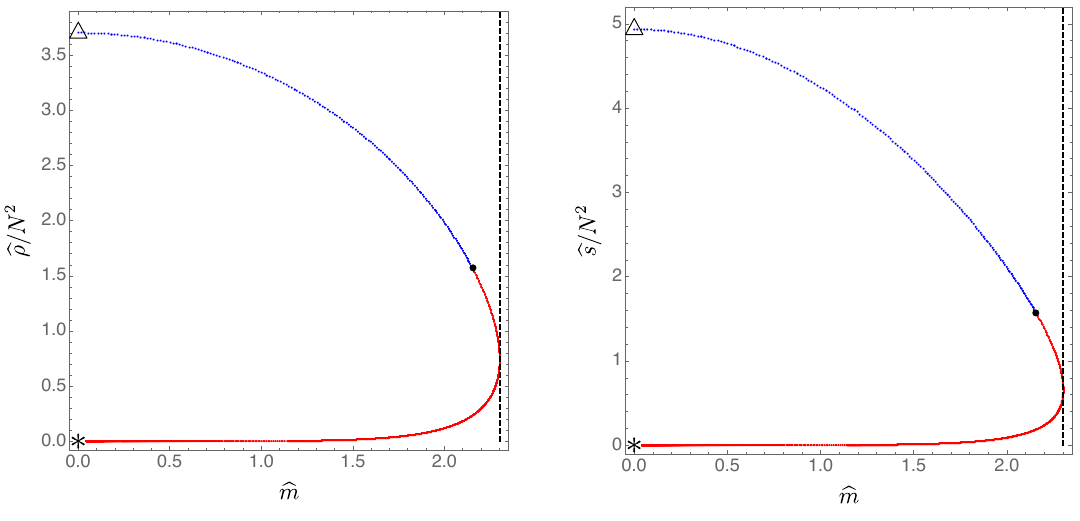
Figure 1 . Energy density (cid:26) ( left panel ) and entropy density s ( right panel ) as a function of the b b mass deformation m (solutions with no gaugino condensate, (cid:27) = 0). The vertical dashed line b intersects the turning point at m = m t (cid:24) 2 : 30; see (3.31). The solution marked with a triangle 4 b b (with m = 0, (cid:26) 6 = 0 and s 6 = 0) corresponds to the planar AdS 5 black hole. The asterisk (cid:3) (with b b b m = 0, (cid:26) = 0 and s = 0) describes a singular solution whose Weyl tensor blows up (see (cid:12)gure 2); b b b we will give strong evidence that it describes the GPPZ solution (2.13). The black disk (cid:15) pinpoints the critical mass deformation m = m c (cid:24) 2 : 15, see (3.34), at which a (most liklely (cid:12)rst-order) phase b b transition occurs (see (cid:12)gure 4). The blue dotted branch of solutions (from (cid:15) to 4 ) dominates the canonical ensemble (since it has negative free energy density) while the red dotted branch (from (cid:15) into (cid:3) ) has positive free energy density: see (cid:12)gure 4. These color and symbol codes will be kept through (cid:12)gures